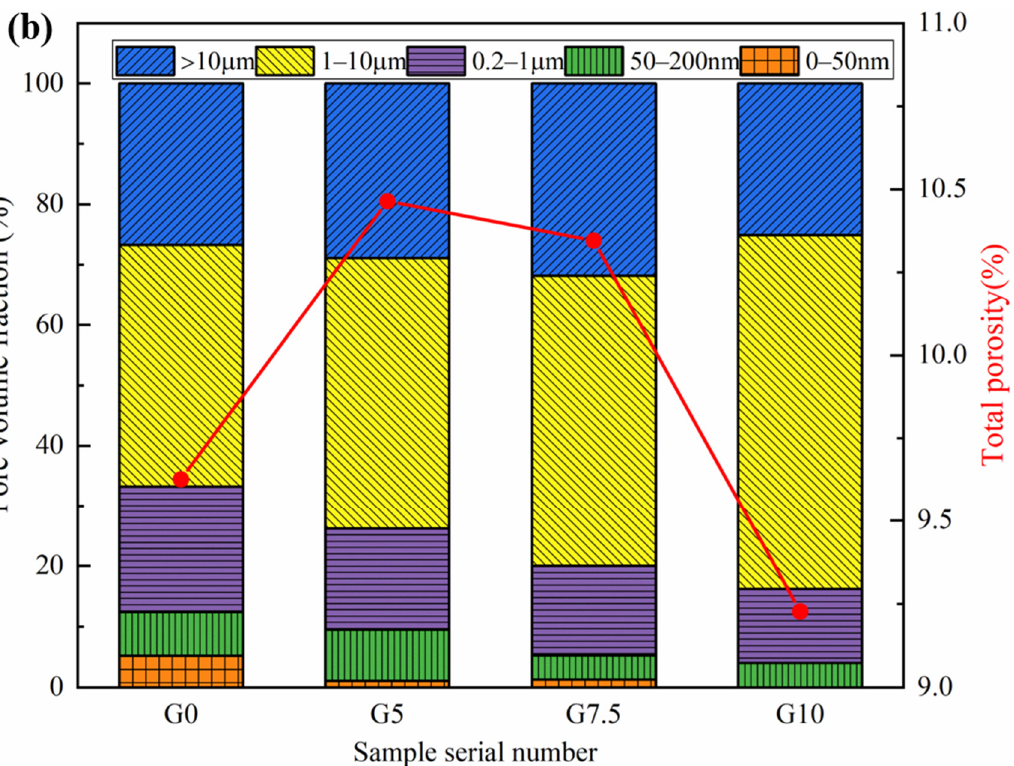
Figure 13. Effect of various modified MgO on the pore structure of MPC after 28 d curing at − 5 °C: ( a ) pore size distribution; ( b ) pore volume fraction and total porosity.